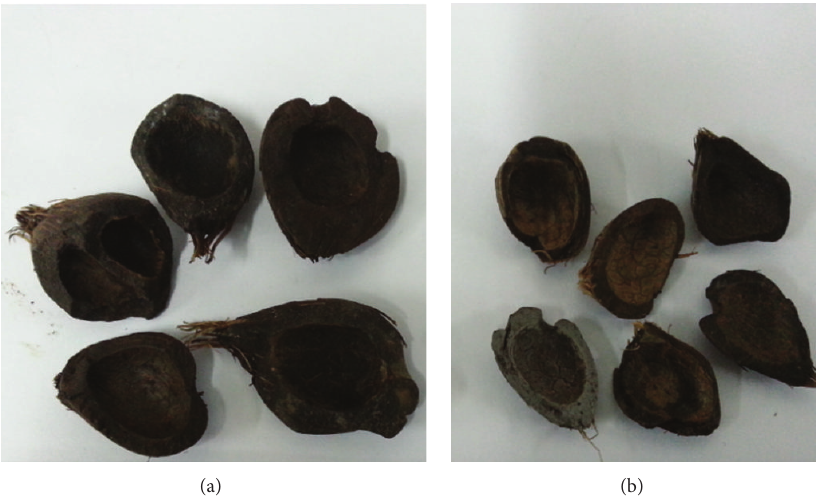
Figure 5: Original dura (a) and tenera (b) OPS coarse aggregates.